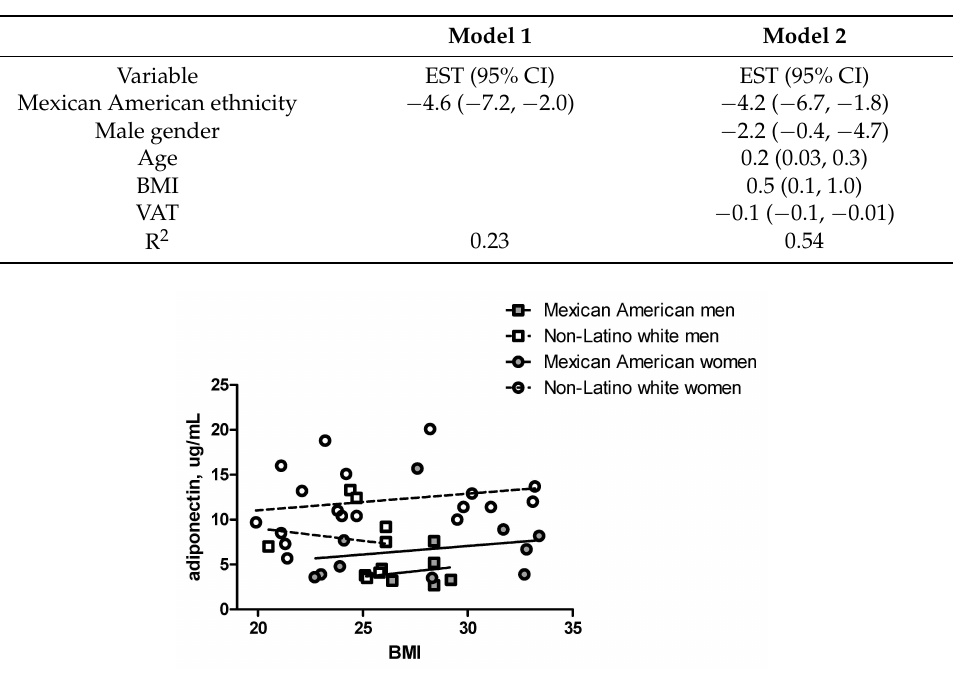
Table 2. ANCOVA with adiponectin as the dependent variable.